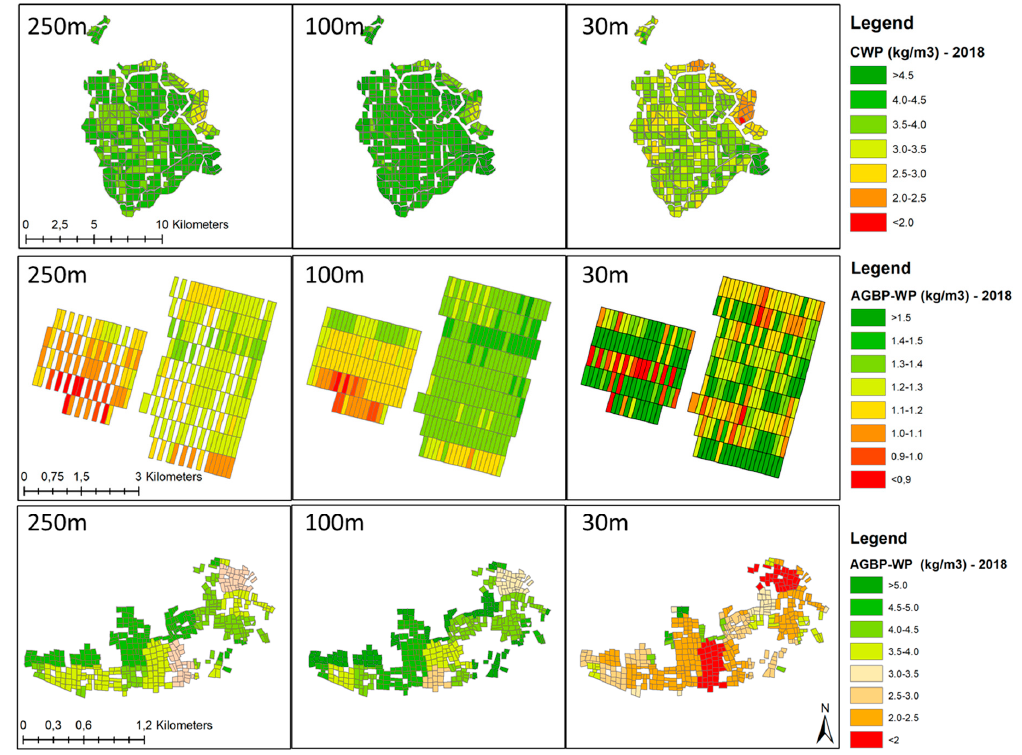
Figure 7. Average plot CWP (2018) in the (upper) Wonji, (middle) ODN, and (lower) Koga (lower) for the L1, L2 and L3